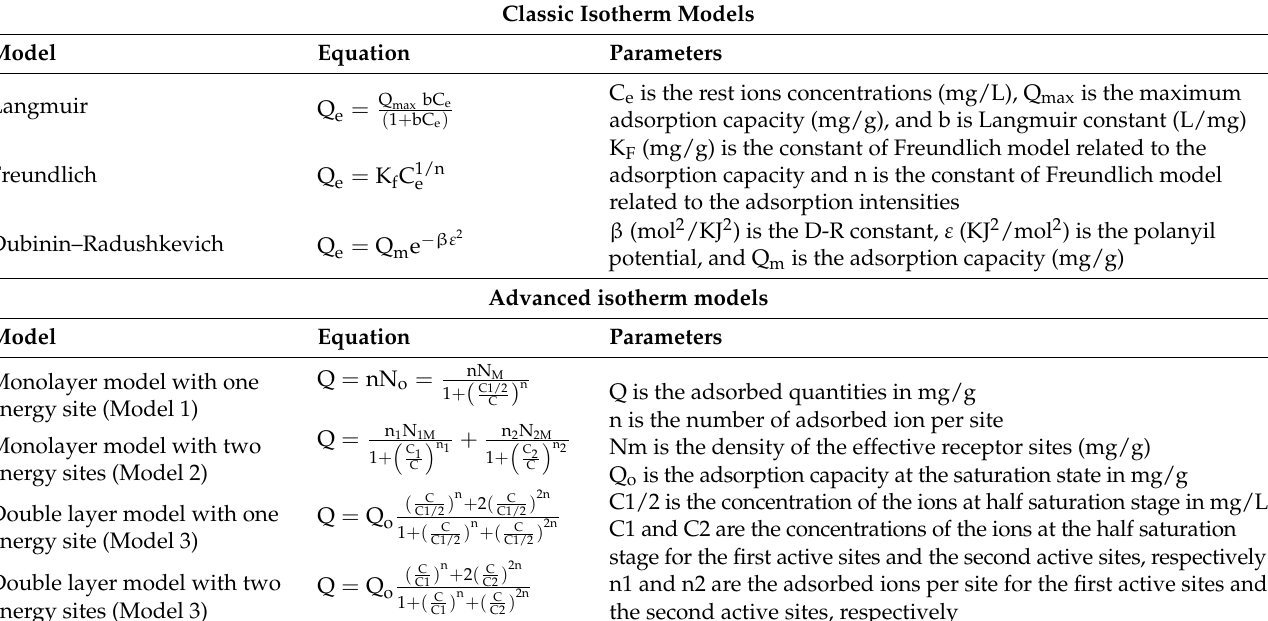
Table 5. Nonlinear equations of kinetic, classic isotherm, and advanced isotherm models. Classic Isotherm